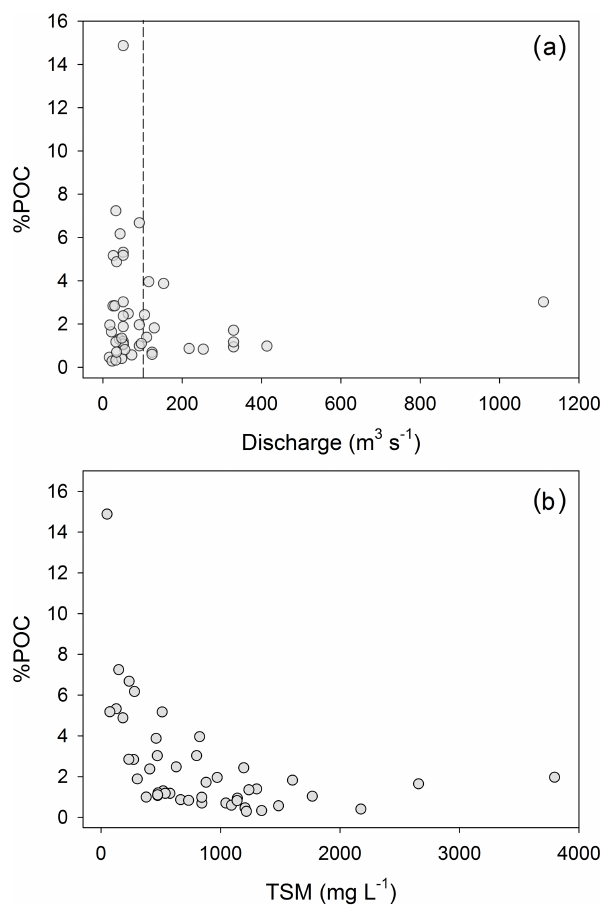
Figure 4. The relationship between the percent contribution of par- ticulate organic carbon to the total suspended load and (a) discharge and (b) total suspended matter. The dashed line in (a) marks dis- charge of 100m 3 s − 1 , as cited in the text.